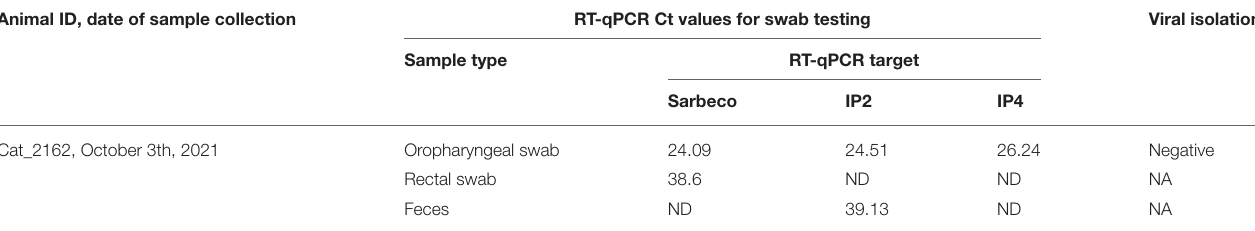
TABLE 1 | SARS-CoV-2 test results for a pet cat from Madrid (Spain) that was confirmed for infection with the B.1.617.2 variant of concern (VOC). Animal ID, date of sample